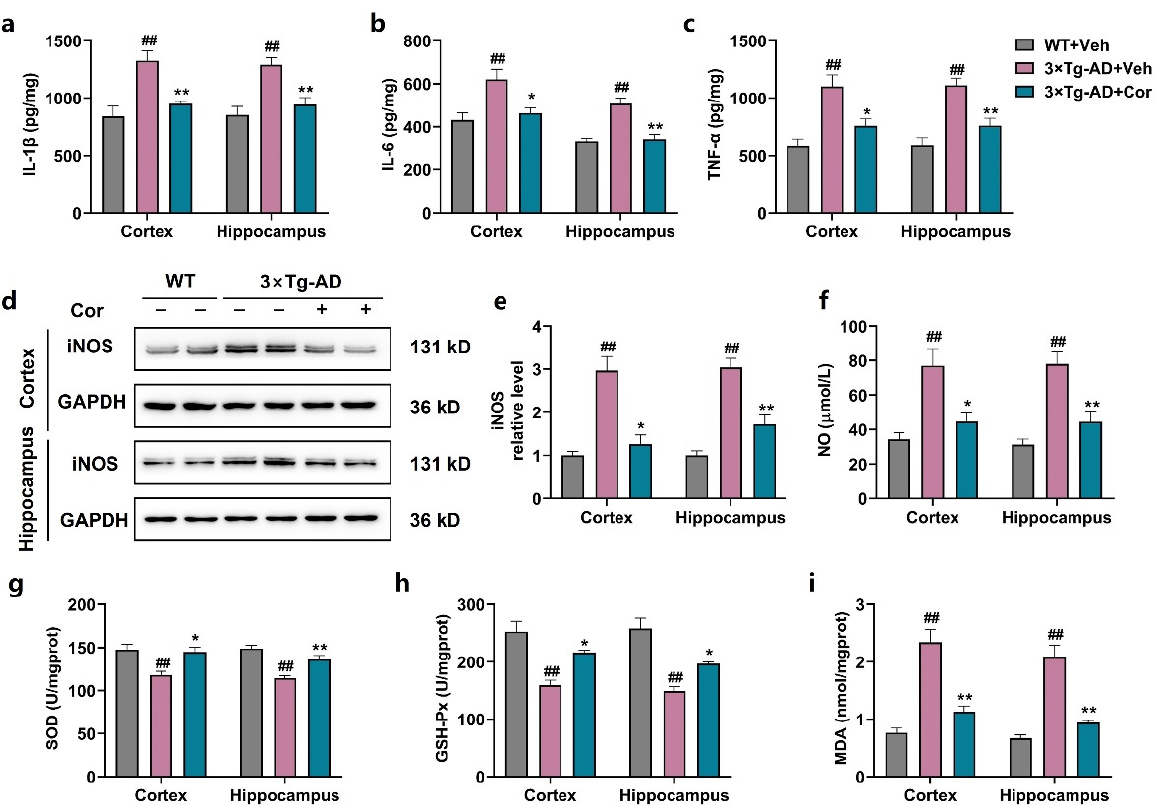
Figure 5. Cornuside reduced neuroinflammation and oxidative stress in the brains of 3 × Tg-AD mice. ( a – c ) Inflammatory cytokines (IL-6, IL-1 β , and TNF- α ) in the cortex and hippocampus of cornuside or vehicle-treated 3 × Tg-AD mice versus WT controls ( n = 5 per group). ( d ) Typical micrographs and ( e ) quantitative assessments of hippocampal and cortical iNOS protein for the 3 × Tg-AD mice administered with cornuside/vehicle versus the WT controls ( n = 6 per group). ( f ) The content of NO in the cortex and hippocampus of cornuside or vehicle-treated 3 × Tg-AD mice versus WT controls ( n = 5 per group). ( g – i ) The GSH-Px, SOD, and MDA expressions in the cortex and hippocampus of cornuside or vehicle-treated 3 × Tg-AD mice in contrast to the WT controls ( n = 5 per group). Values are all expressed as mean ± SEM. ## p < 0.01 compared with WT-Con; * p < 0.05 and ** p < 0.01 compared with 3 × Tg-AD group.